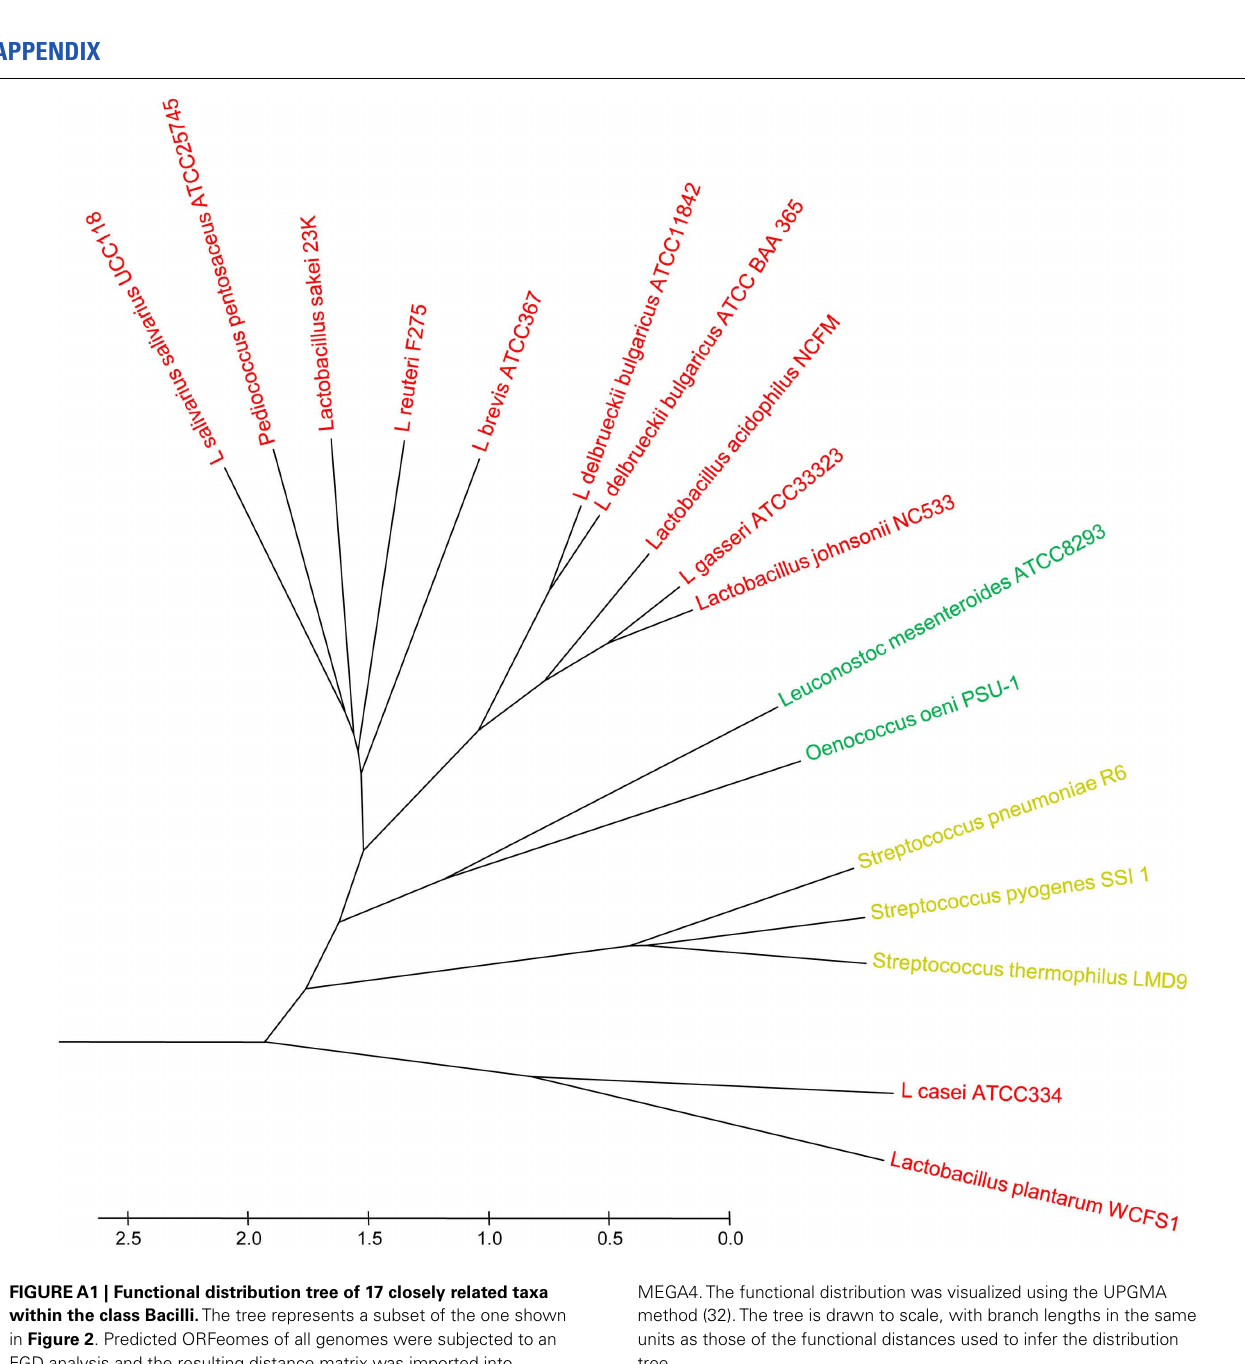
FIGUREA1 | Functional distribution tree of 17 closely related taxa within the class Bacilli. The tree represents a subset of the one shown in Figure 2 . Predicted ORFeomes of all genomes were subjected to an FGD analysis and the resulting distance matrix was imported into